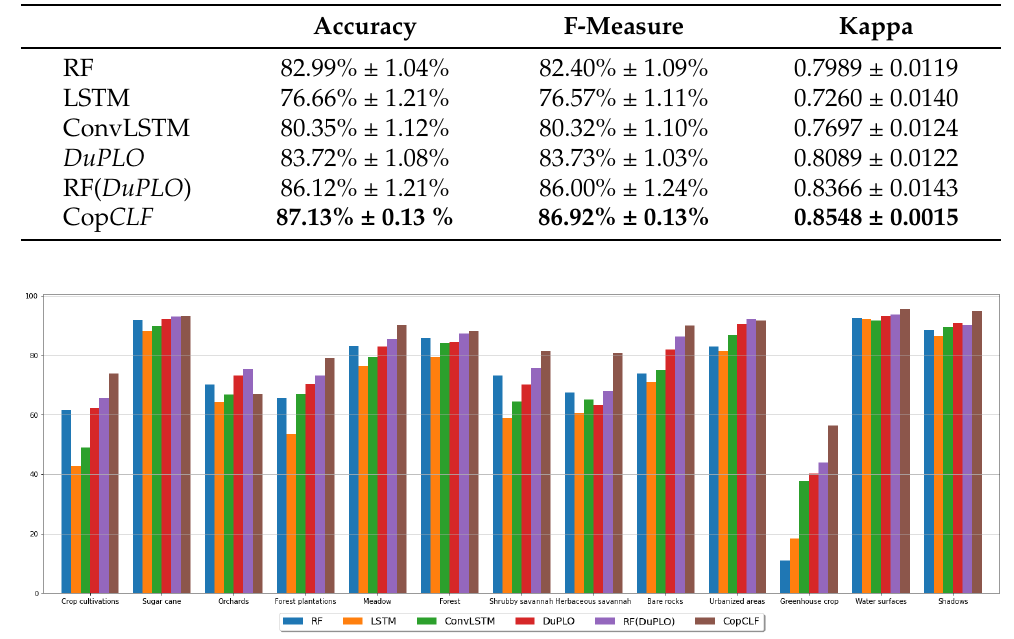
Figure 3. Per-Class F-Measure score of different